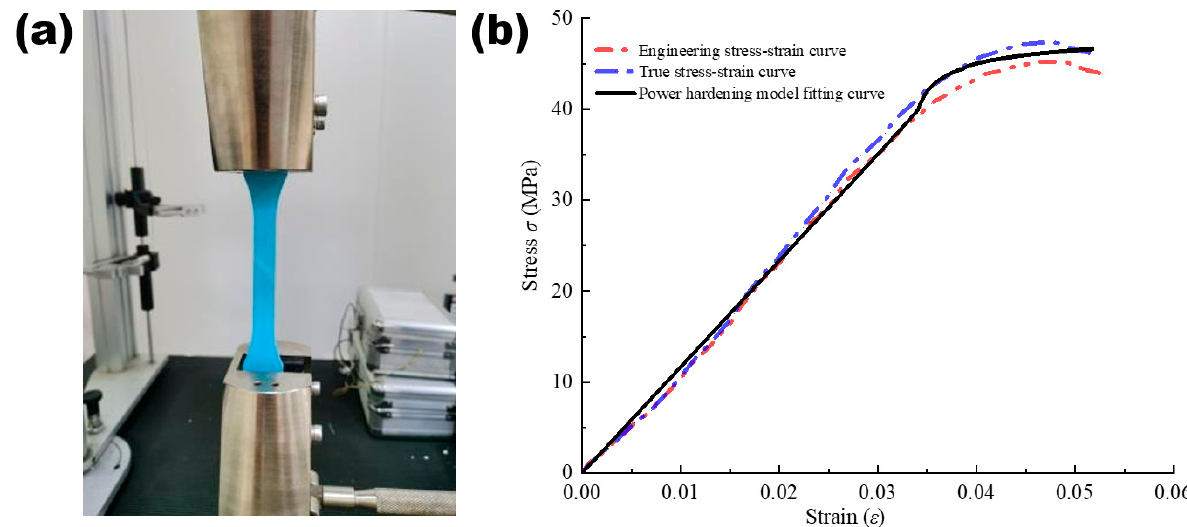
Figure 7. Stress–strain curve of PVC material and tensile loading device: ( a ) tensile testing and ( b ) stress–strain curve. Table 1. PVC material tensile testing